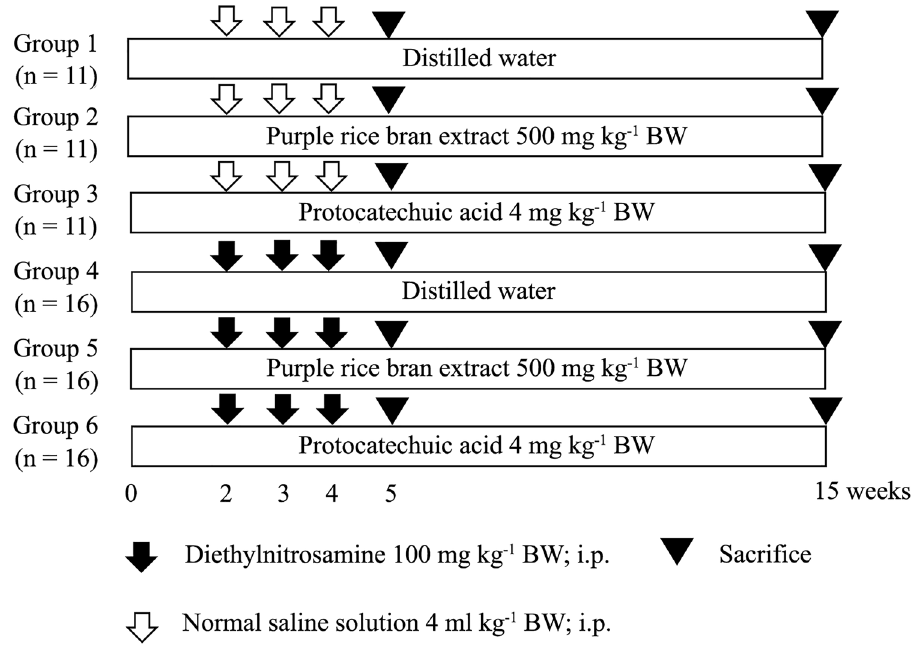
Figure 1. Experimental protocol for testing the anticarcinogenic effect of purple rice bran extract and protocatechuic